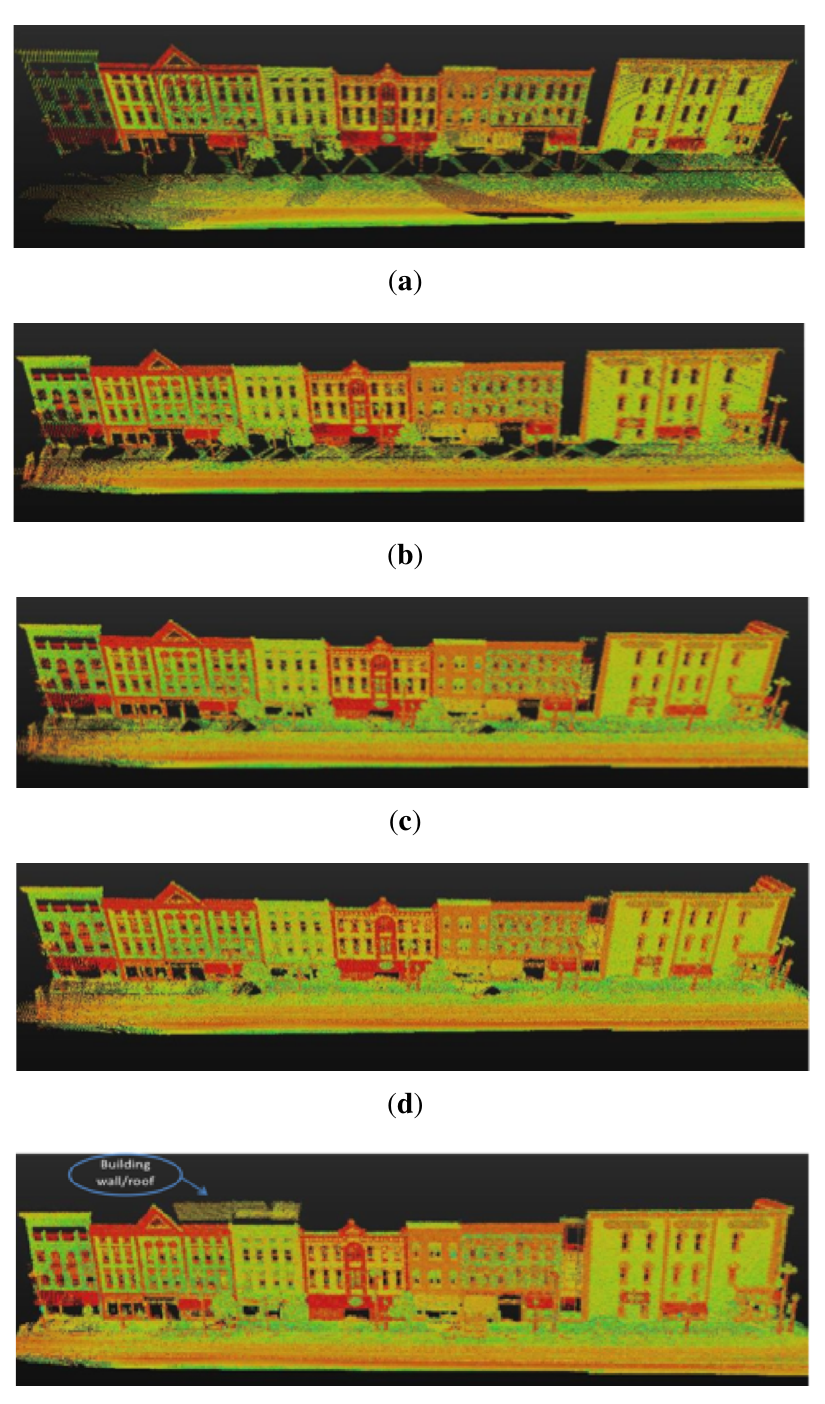
Figure 12. ( a ) Shows the initial point cloud related to urban cartography full of imperfections. In ( b ), ( c ) and ( d ), completion of occluded and missing features in the urban cartography, by incremental updating, using the default sequential update function as a change of type-1 is detected. ( e ) shows the point cloud after the object update function; certain parts of the roadside and building walls are added to the 3D cartography after ) , after first passage; (b) 3D repetition in subsequent passages. (a) 3D point cloud, P ( n p ) , after second passage; (c) 3D point cloud, P ( n ) , after third passage; (d) point cloud, P ( n p p ) , after fourth passage; (e) 3D point cloud, P ( n ) , after object 3D point cloud, P ( n p p